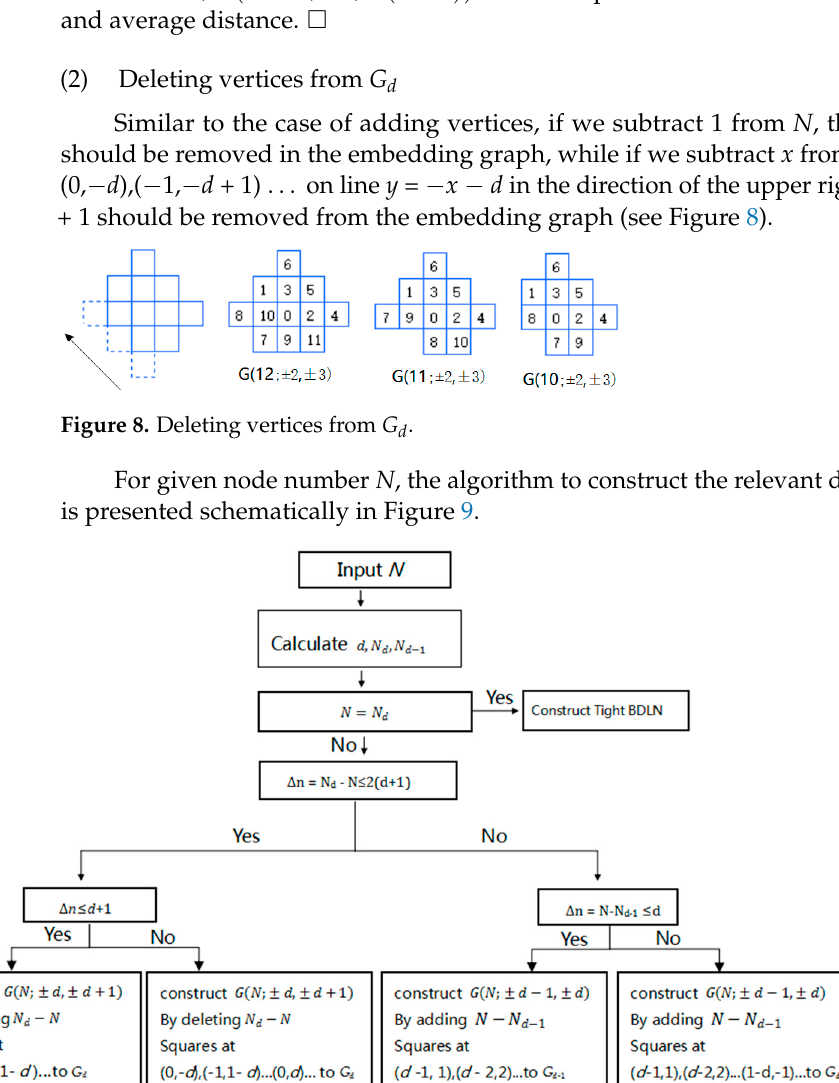
Figure 9. Algorithm for constructing a dual optimal BDLN.